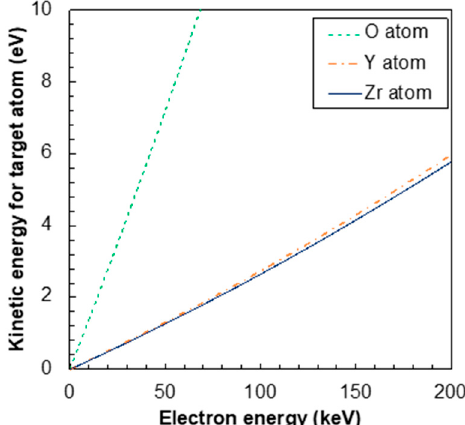
Figure 7. Kinetic energy transfer for Zr, Y, and O atoms due to elastic scattering as a function of the energy of the incident electron.